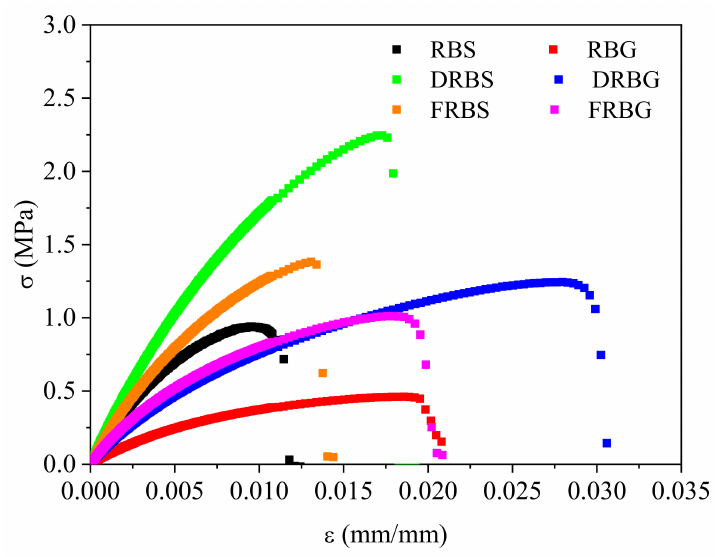
Figure 3. Stress-strain curves obtained for the different evaluated systems at 1 mm/min and room